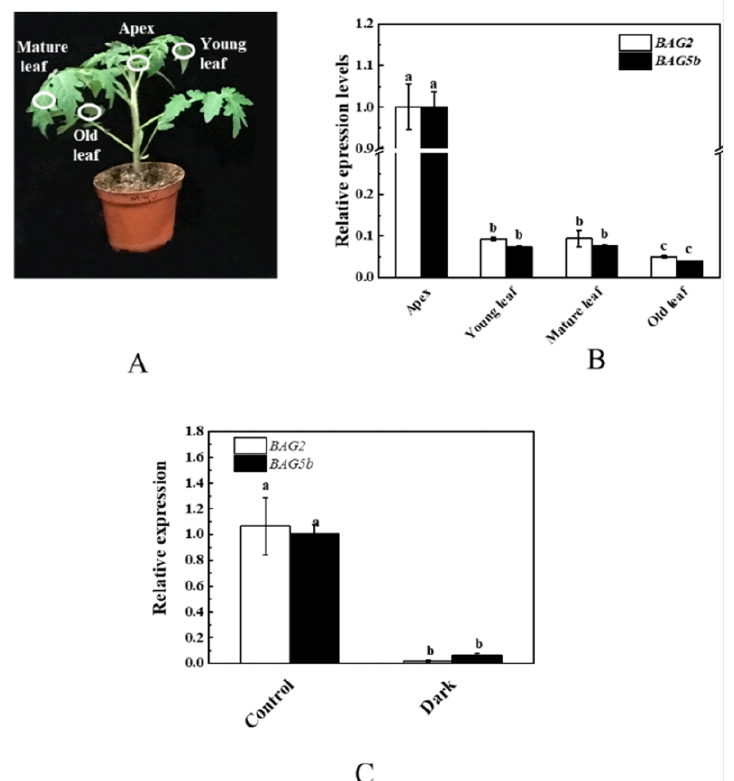
Figure 7. Expression pattern analysis of BAG2 and BAG5b in wild-type (WT) plants under dark treatment. ( A ): Different parts of seedlings before dark stress; ( B ): levels of BAG2 and BAG5b transcripts were determined by qPCR in apex, young leaf, mature leaf, old leaf of WT plants developed in dark stress for 10 d. For both genes, the expression level in the apex was set as 1.0; ( C ): BAG2 and BAG5b expression in leaves treated with darkness was detected by qPCR. The transcripts of both genes in 0 d were set as 1.0. Different letters indicate expression levels that were significantly different at P <